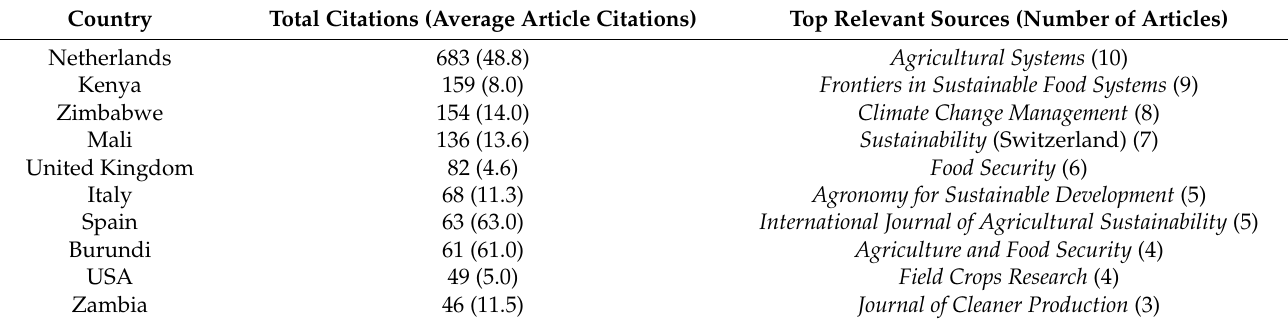
Table 2. Top ten total citations per country and top publication